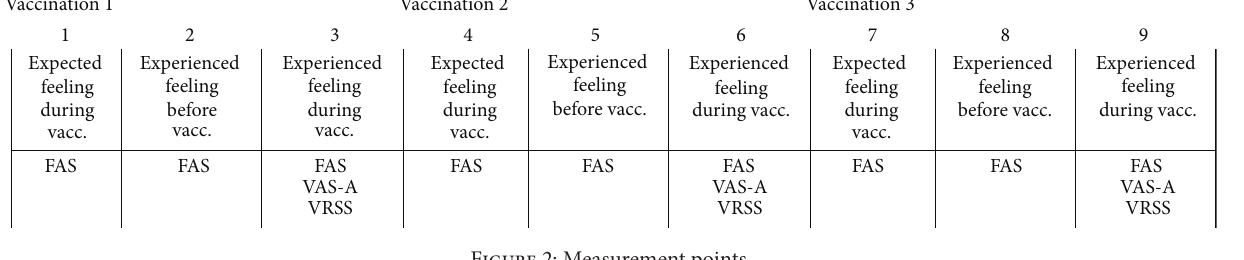
Figure 2: Measurement points.